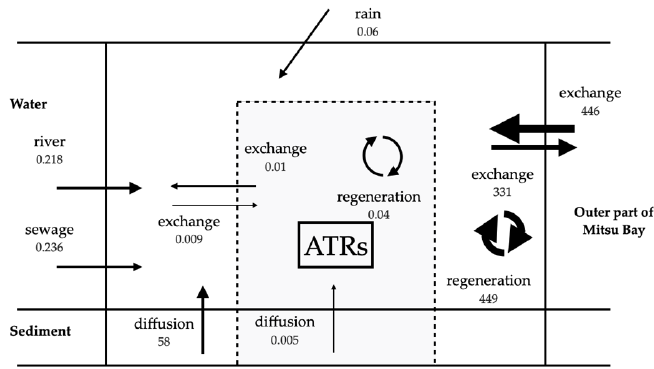
Figure 6. Annual average phosphorus flows (kg P day −1 ) from various sources in the ATR areas (V: 3200 m −3 ) and in Mitsu Bay (V: 144,000,000 m −3 ). Arrow thickness represents their contributions (Thick arrow: >10 kg P day −1 , moderate arrow: 0.1–10 kg P day −1 . thin arrow: 0–0.1 kg P day −1 ). The square indicating the imaginal demarcation between the ATR area and Mitsu Bay.